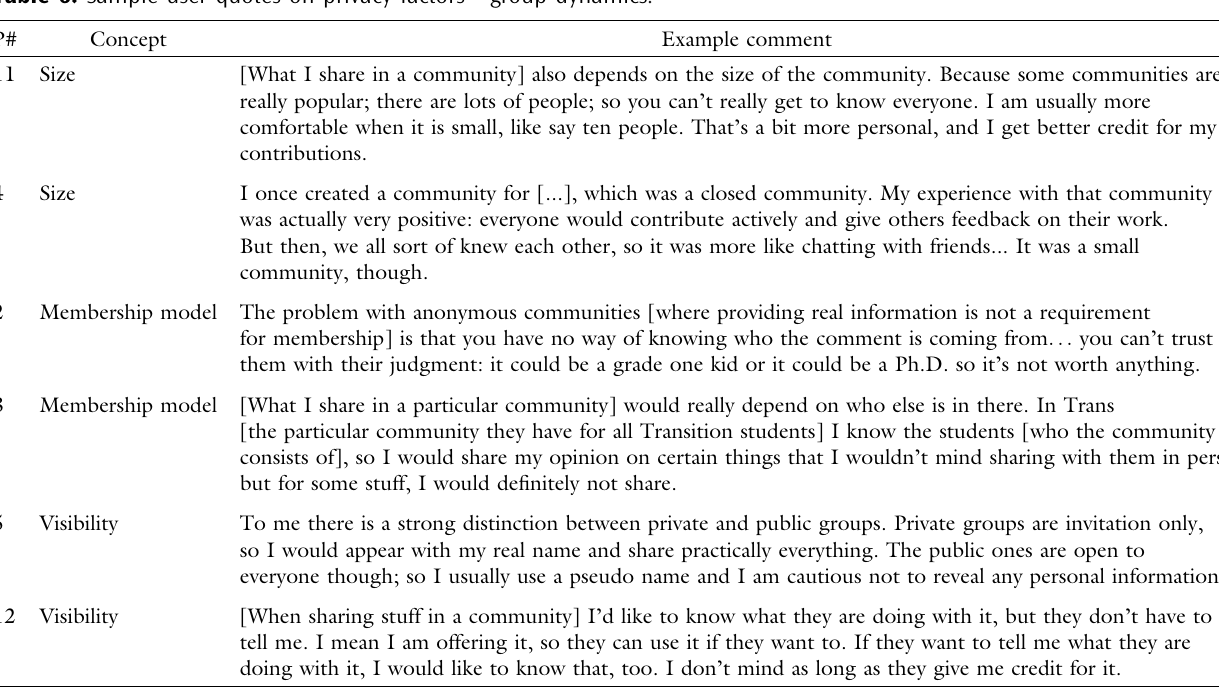
Table 6. Sample user quotes on privacy factors—group